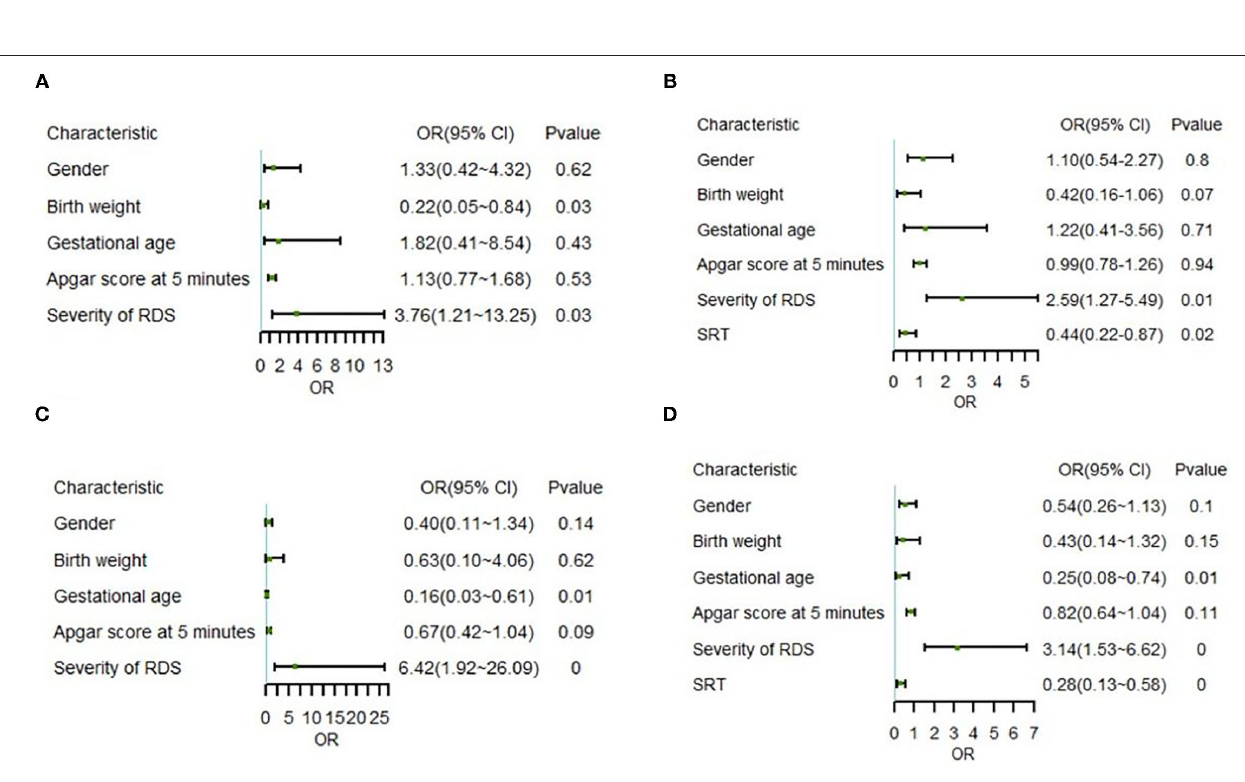
Frontiers in Pediatrics |